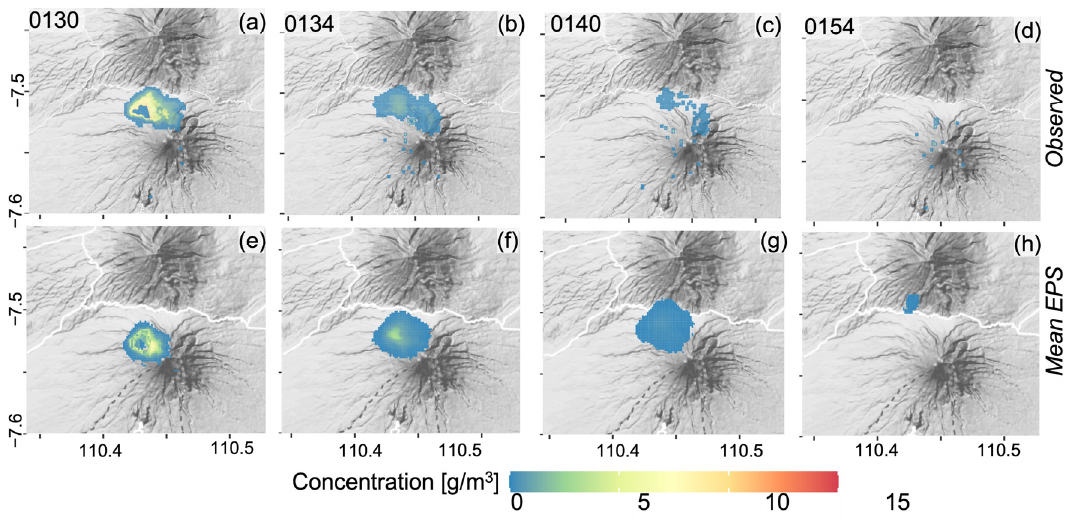
Figure 7. The retrieved tephra concentration on M06 based on valid Z H ( a – d ) compared with the mean EPS ( e – h ) at different time steps, as indicated in the top left corner. The mean EPS uses a threshold of tephra concentration ≥ 0.01 g/m 3 . In each image, the x -axis is longitude and y -axis is